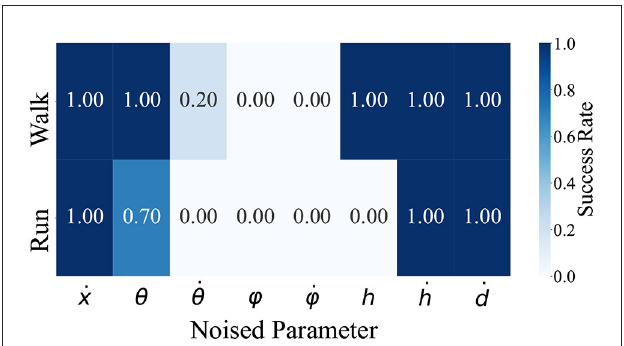
FIGURE5 The average model velocities for the input ω v . The purple and gray points denote the ratio of the DS and F phase in the gait cycle respectively. The controller generated steady gaits in the bipedal ω v model for 0 2.93, even though we did not train with ≤ ≤ ω v 2.5 2.93 (orange hatched area). This graph shows the plots ≤ ≤ when the input command ω v was given in the range of 0.0–2.93 in 0.01 intervals. For each ω v , the biped model locomoted for a distance of 30 m from the initial state.